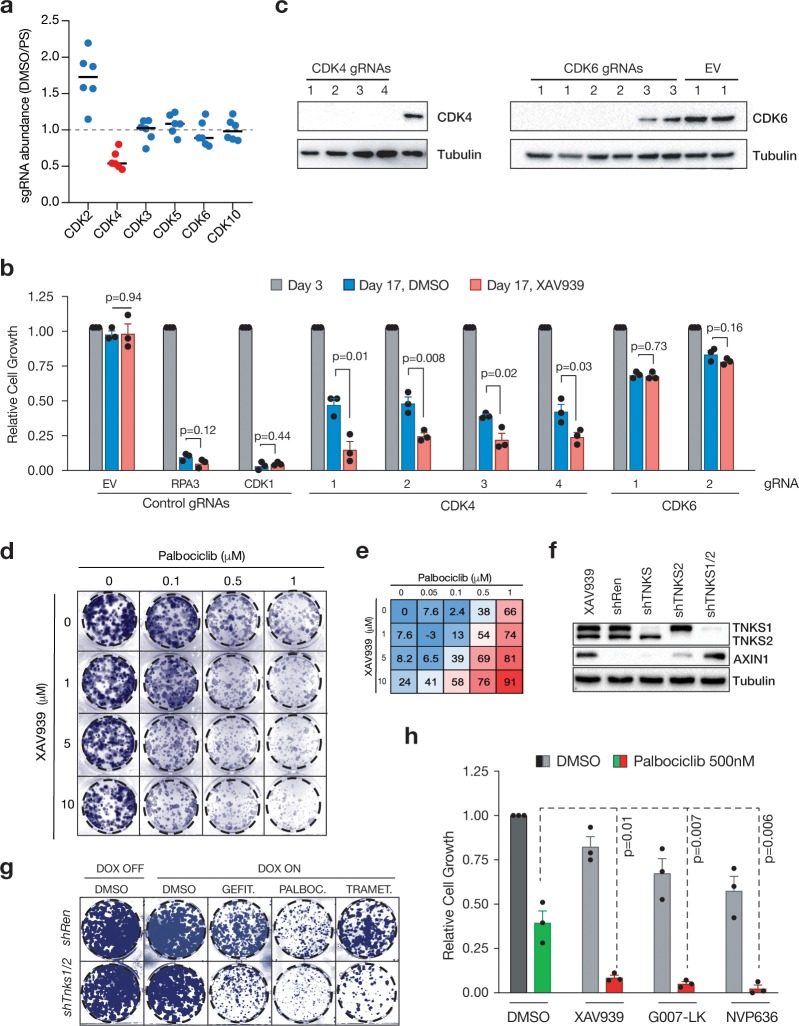
Simultaneous inhibition of TNKS and CDK4 is synthetic lethal.a. Normalized gRNA counts of Cyclin-dependent kinase (CDK) family members (DMSO D17 values, normalized to Sorting D3). b. Fluorescence-based gRNA competition assays by flow cytometry. Shown in mean and SEM, n = 3 independent DLD1 clones. P values were calculated using two-tailed Student’s t test. EV = control empty gRNA vector. c. Western blot in DLD1-LC9 cells stably transduced with CDK4 or CDK6 gRNAS and selected in Puromycin and Blasticydin for 5 days. d. Colony forming assays of DLD1 cells grown in 10% FBS in the indicated inhibitor concentrations. e. Growth inhibition scores, shown as % of growth inhibition (normalized to non-treated conditions), of DLD1 cells in the indicated inhibitor concentrations. f. Western blot showing TNKS silencing with single or tandem shRNA constructs in DLD1 cells. Tandem TNKS silencing induces AXIN1 protein to a similar level as treatment with XAV939. g. Colony forming assays of DLD1 cells stably transduced with the indicated dox-inducible TNKS1/2 or Renilla shRNAs, respectively, and grown in colony-forming conditions in the presence of the indicated inhibitors +/- dox. TNKS1/2 shRNAs efficiency by western blot (bottom). g. Relative growth of DLD1 cells grown in colony-forming conditions in the presence of the indicated inhibitors +/- Palbociclib. N = 3 independent experiments, mean and SEM are shown (Student’s t test).